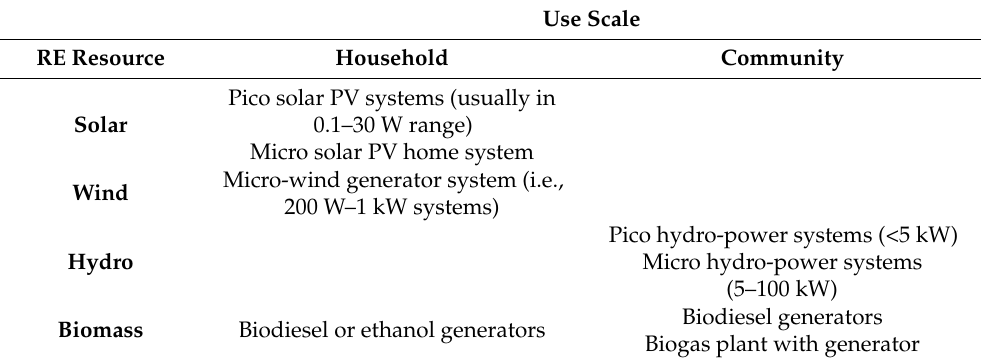
Table 8. Potential renewable energy technologies to be applied to afford electricity